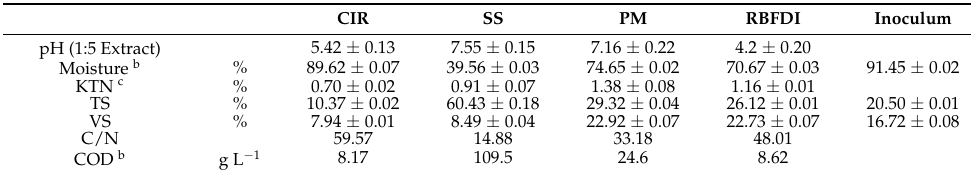
Table 1. Physicochemical characteristics of the inoculum and substrates a